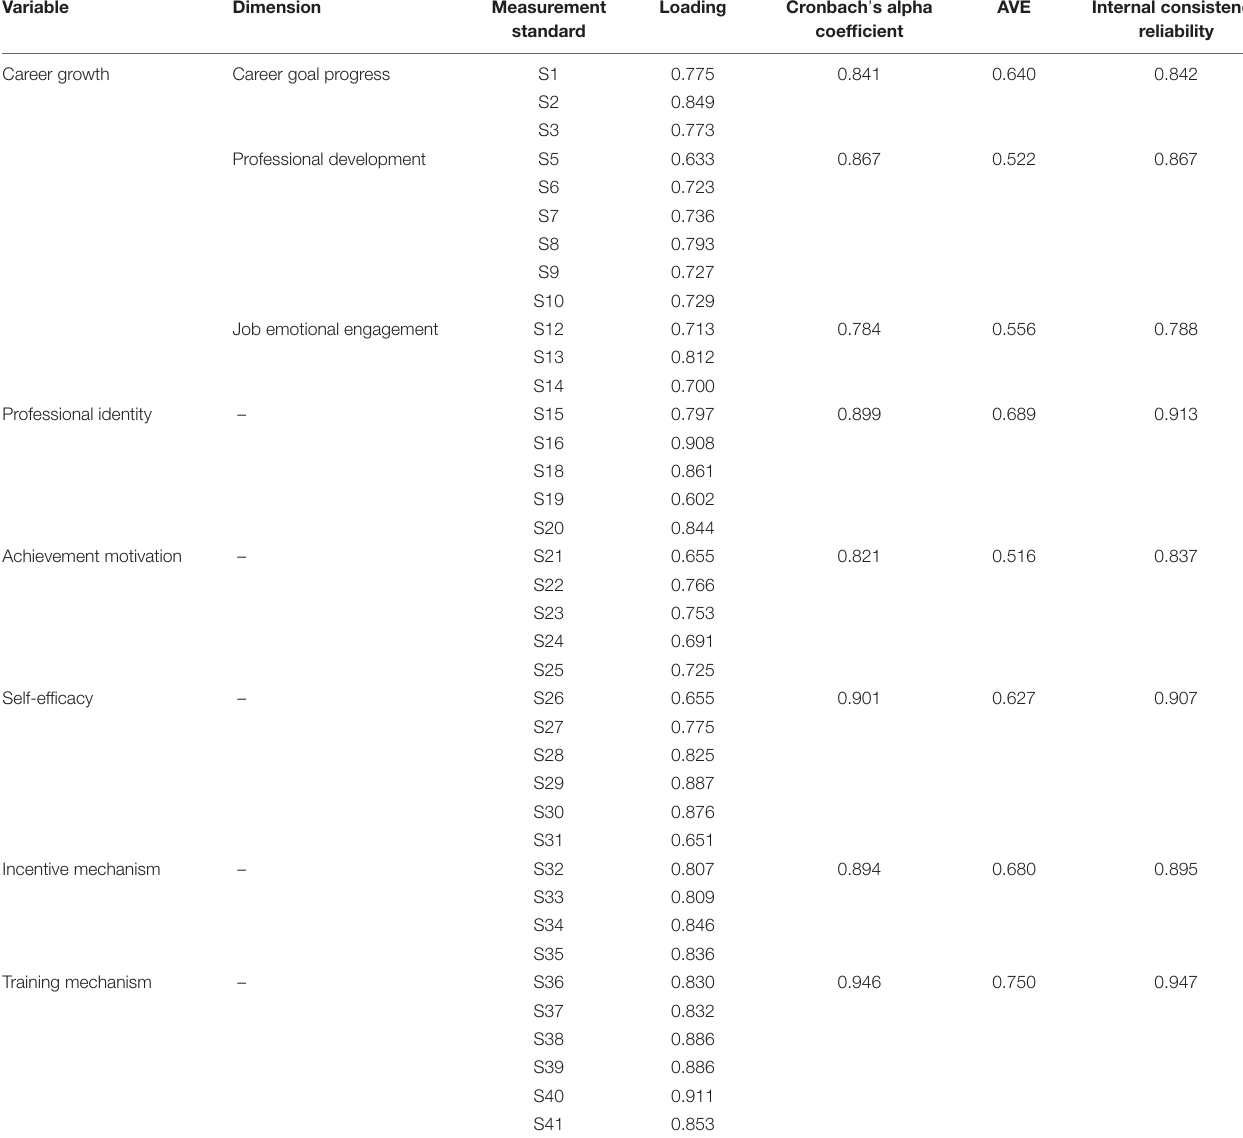
TABLE 2 | Reliability and validity analysis